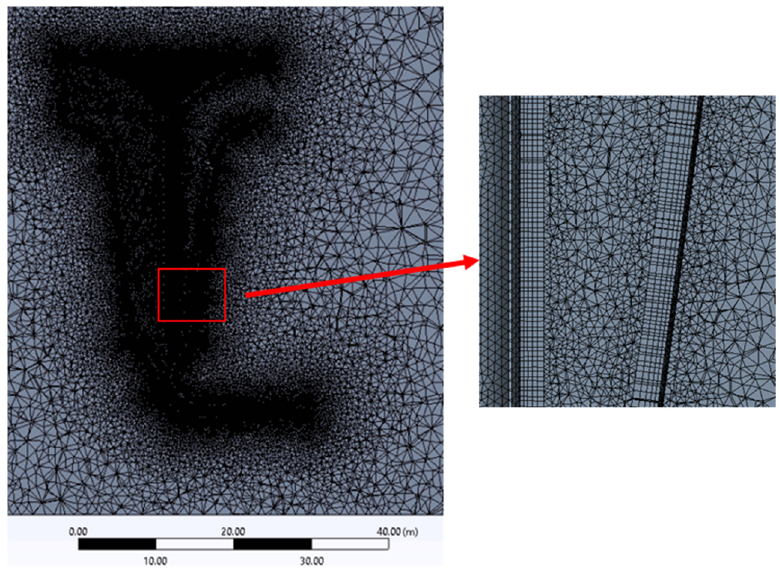
Table 2. Comparison with previous research of the performance of the proposed omni-directional wind funnel in terms of its speed ratio (SR). Figure 3. Meshing of the omni-directional wind funnel. Figure 3. Meshing of the omni-directional wind funnel.